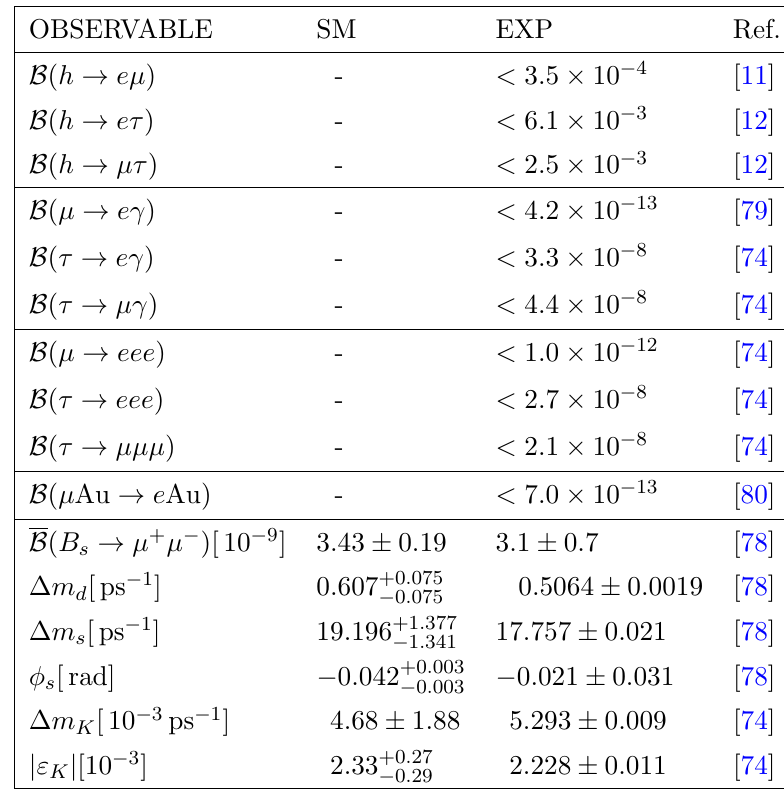
Table 2 . SM predictions and experimental measurements for the observables used in the numerical analysis. Upper bounds for the Higgs LFV decays are values corresponding to 95% CL, while the other LFV processes 90%